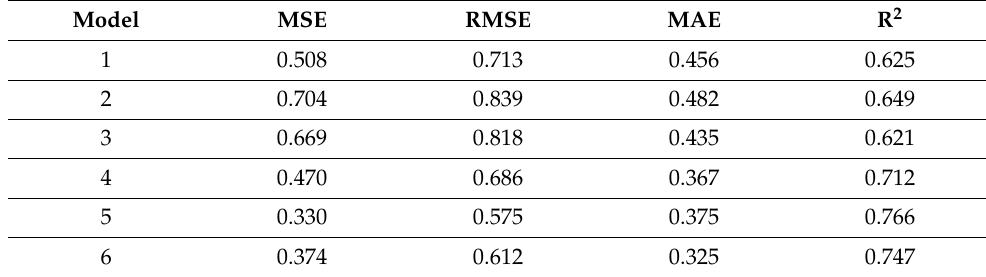
Table 7. Model validation results of set 2 for the slurry test with SAND_PRODUCED as the output. Model